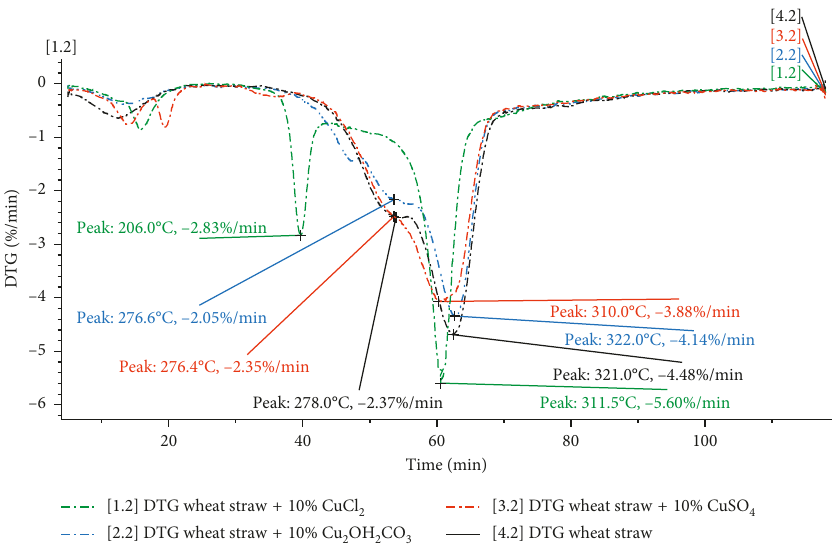
Figure 5: DTG curves obtained as a result of pyrolysis of wheat straw in the presence of copper salts.